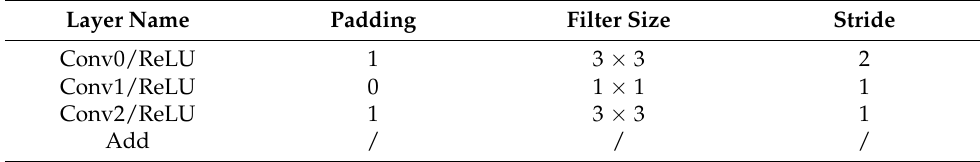
Table 2. Information of each layer of the residual block. Layer Name